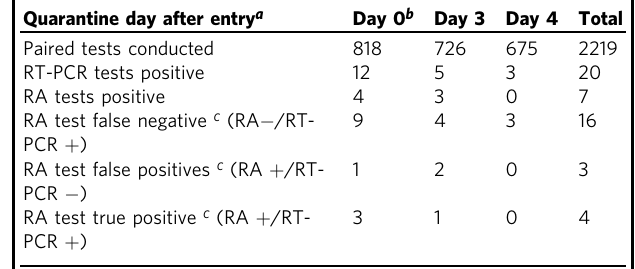
Table 1 Paired BD Veritor and RT-PCR tests conducted, results, their agreement, and false